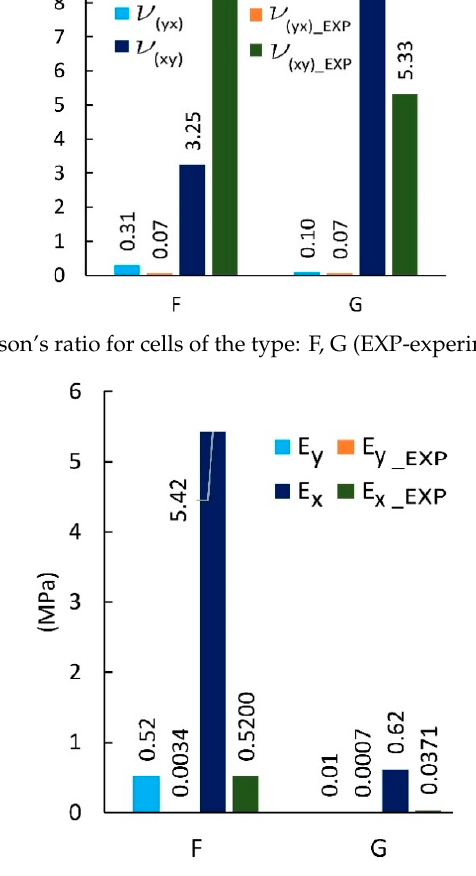
Figure 11. Modulus of linear elasticity for cells of the type: F, G (EXP-experimental research).